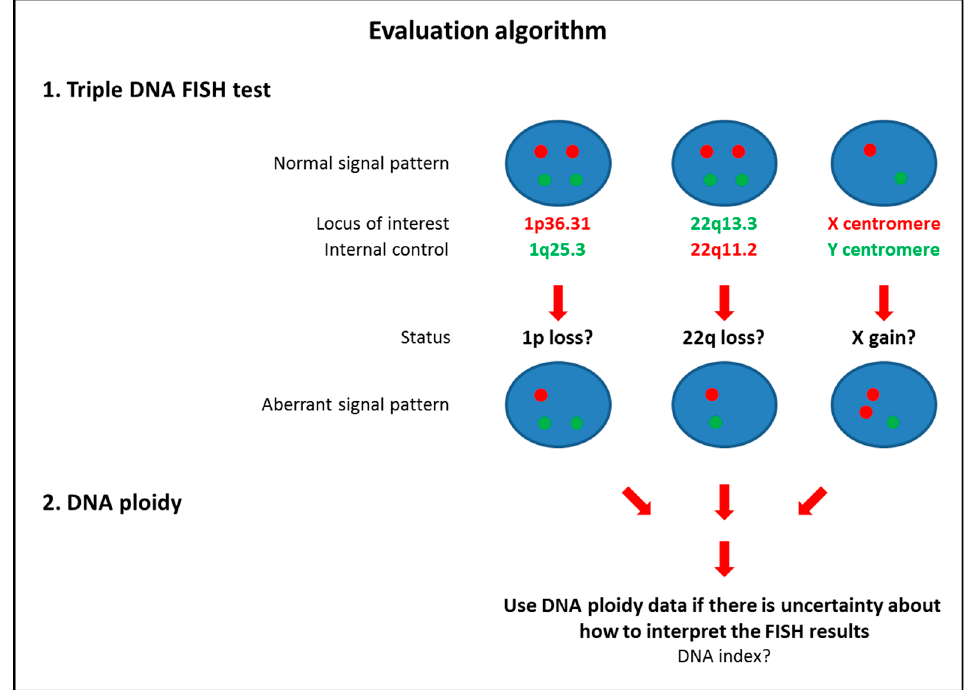
Figure 7. The evaluation algorithm of the Triple DNA FISH diagnostic assay depicts the main three normal and aberrant signal patterns observed in samples from cFA and cFTC, respectively.